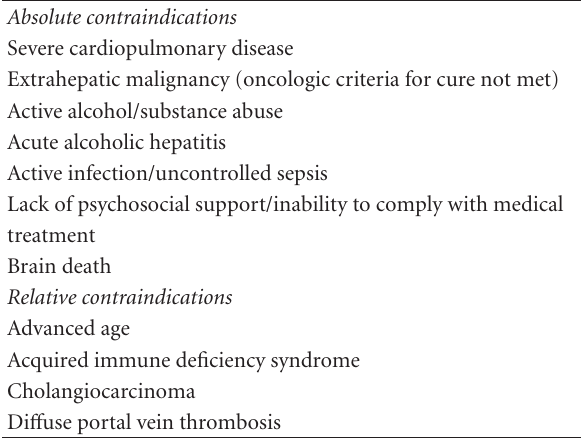
Table 6: Contraindications to liver